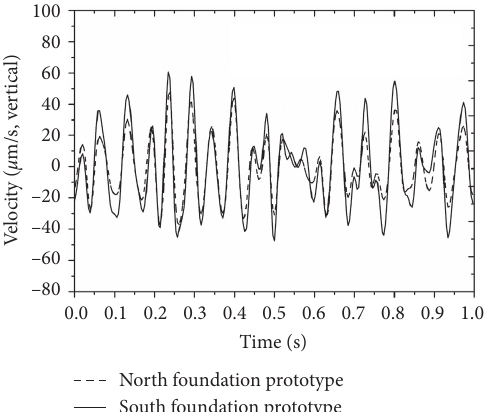
Figure 18: Predicted velocity time histories of the surface vibra- tions of the two foundation prototypes.